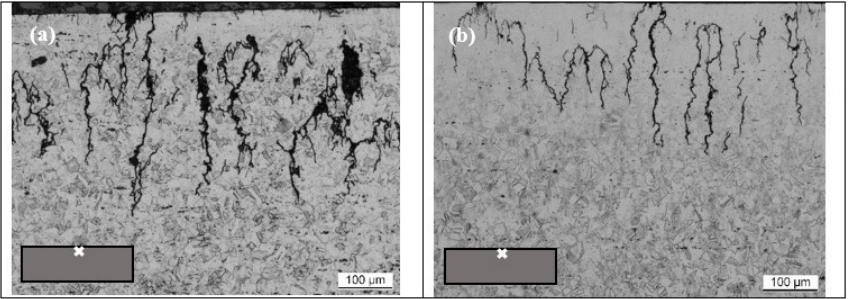
Figure 11. Light microscopic images of cross sections parallel to longitudinal axis through specimen loaded at 250 MPa and torsional angle of 10 ◦ ( a ) and 350 MPa and 7.5 ◦ ( b ). Branches of main cracks are visible, propagating in radial direction below the